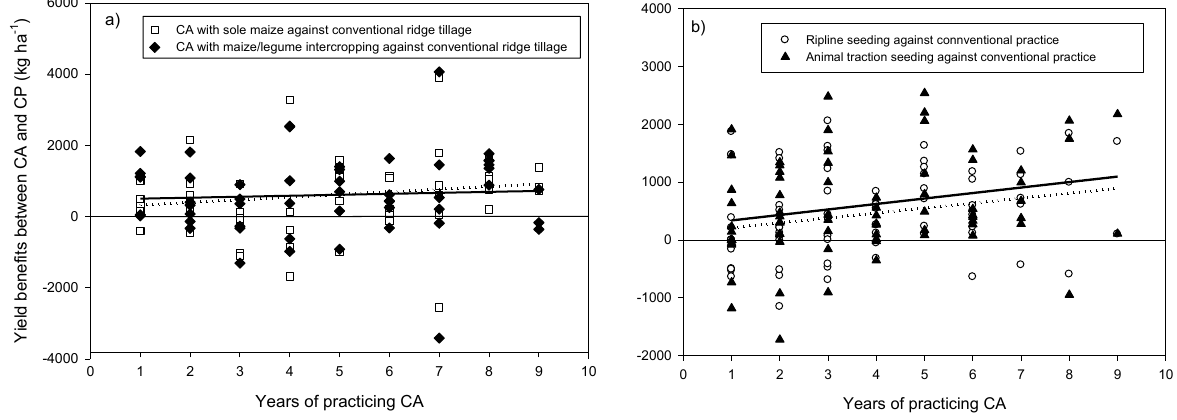
Figure 3. Yield benefits of conservation agriculture systems against a conventional practice on-site in response to increased years of practice at Zidyana, Malawi ( a ) and Zimuto, Zimbabwe, ( b ) Yield benefits are calculated as yields of the CA system minus yield of the conventional